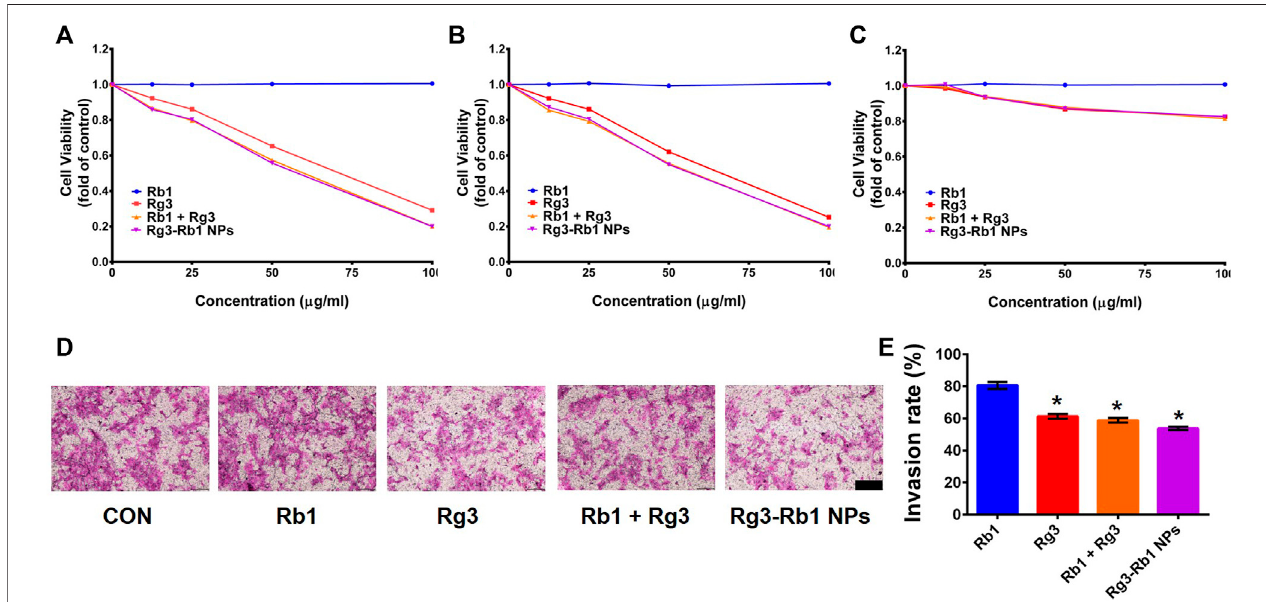
FIGURE 3 | In vitro pharmacological effect of Rg3-Rb1 NPs. Cell viability of (A) 4T1, (B) MDA-MB-231, and (C) MCF-10a cells after 48 h of treatment. (D) Representative images and (E) quantitative analysis of crystal purple-stained invasive 4T1 cells. Scale bar = 200 μ m p p < 0.05 compared with the control group. NPs,